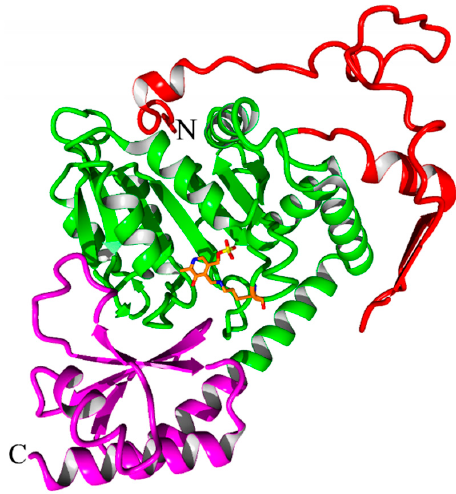
Figure 3. The structure of hKAT-II. The secondary structure elements are shown with the cofactor, PLP. The N-terminal arm is depicted in red, the large domain in green, the C-terminal arm is in magenta and the LLP263 is shown in orange stick representation. The termini are labelled with N and C.